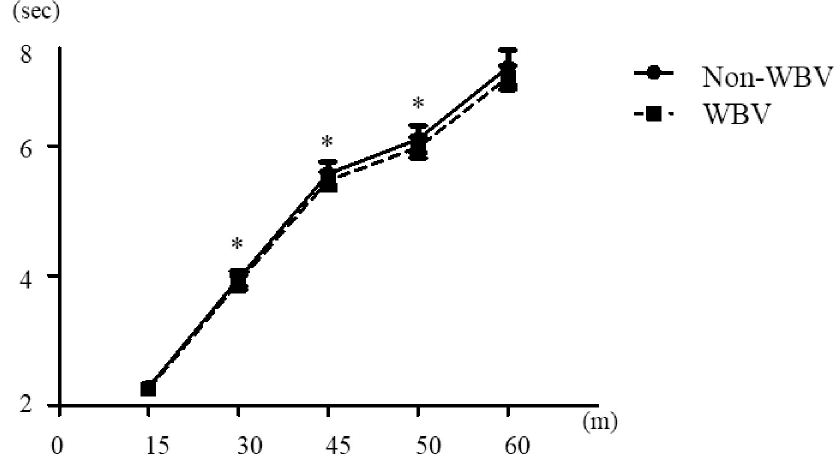
Fig 1. Sprint cumulative record of males. Data in the graph represent the means ± standard deviation. � Analyzed by paired t-test, � p < 0.05.